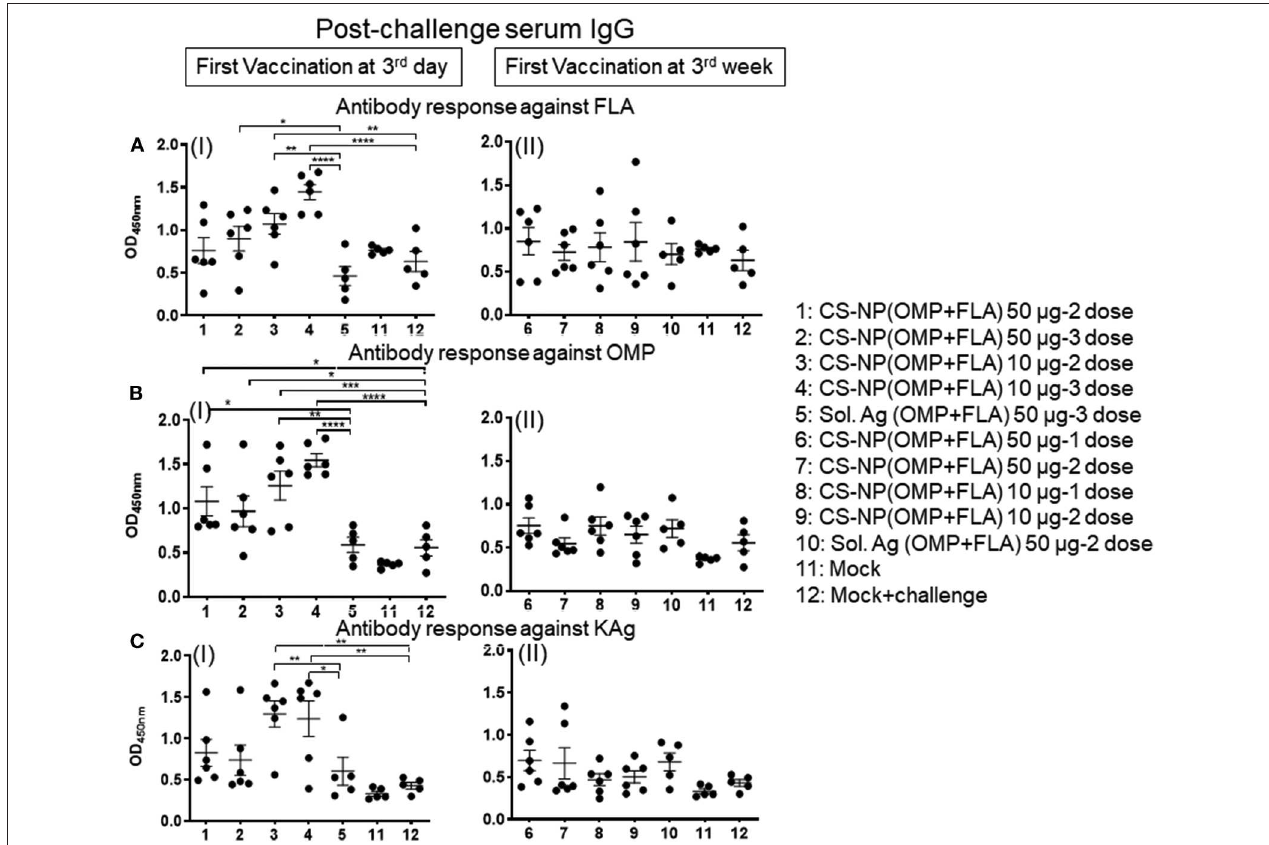
FIGURE 3 | Specific IgG response in vaccinated birds post-challenge infection. Broilers were vaccinated as described in Fig legend 1, challenged at age 5-week, 10 days later euthanized and serum samples collected were analyzed for specific IgG antibody response by ELISA: against (A) FLA protein (I and II), (B) OMP (I and II), and (C) KAg (I and II). Data were presented as mean ± SEM of 6 or 5 birds. Significant difference between the indicated two groups were determined by one-way ANOVA followed by Tukey post-hoc test. * P < 0.05, ** P < 0.01, *** P < 0.001, **** P < 0.0001.